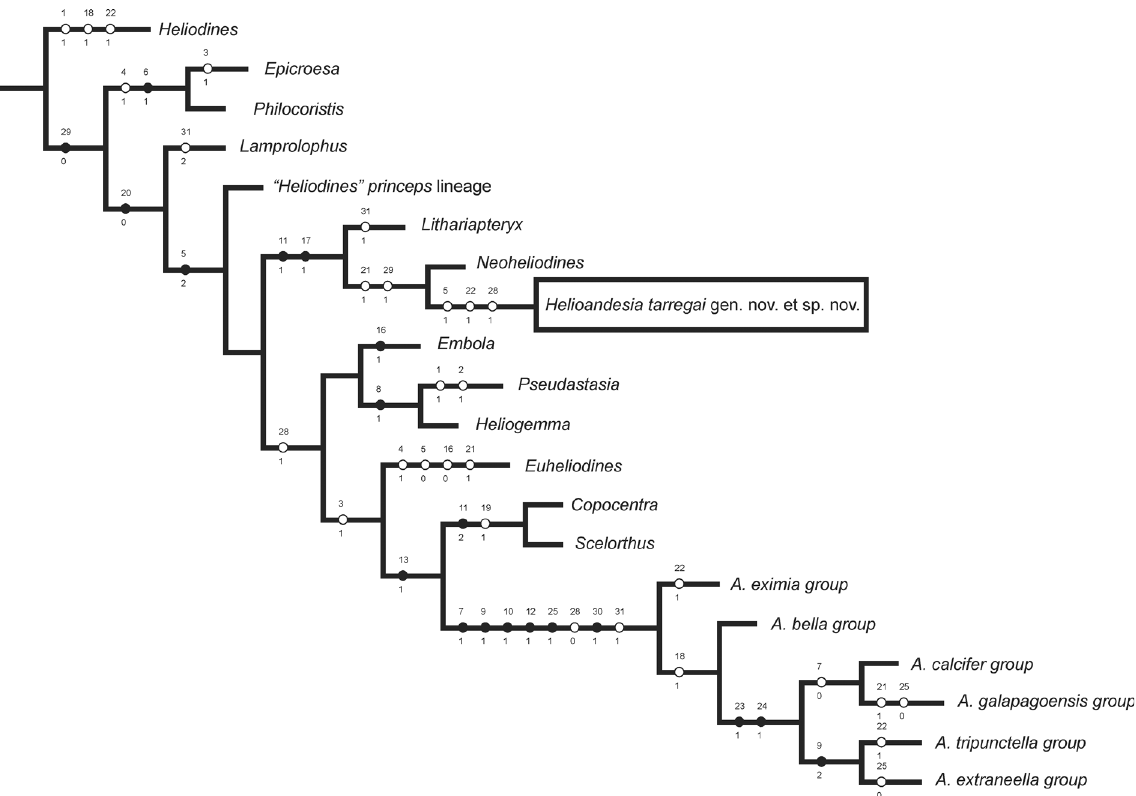
Fig. 1. Strict consensus (85 steps, consistency index 52, retention index 75) of the four most parsimonious trees, showing the phylogenetic relationships of Helioandesia tarregai gen. et sp. nov. (rectangle) based on the data matrix provided by Hsu & Powell (2004). Only unambiguous changes are shown. Outgroups not shown.